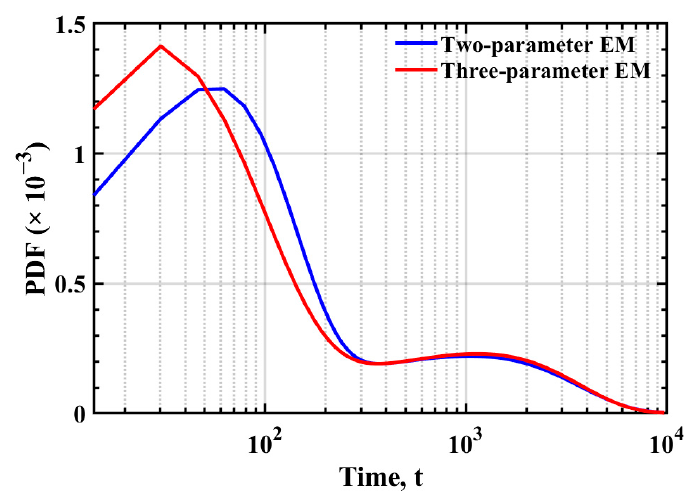
Figure 8. Fitted probability density functions of failure times.